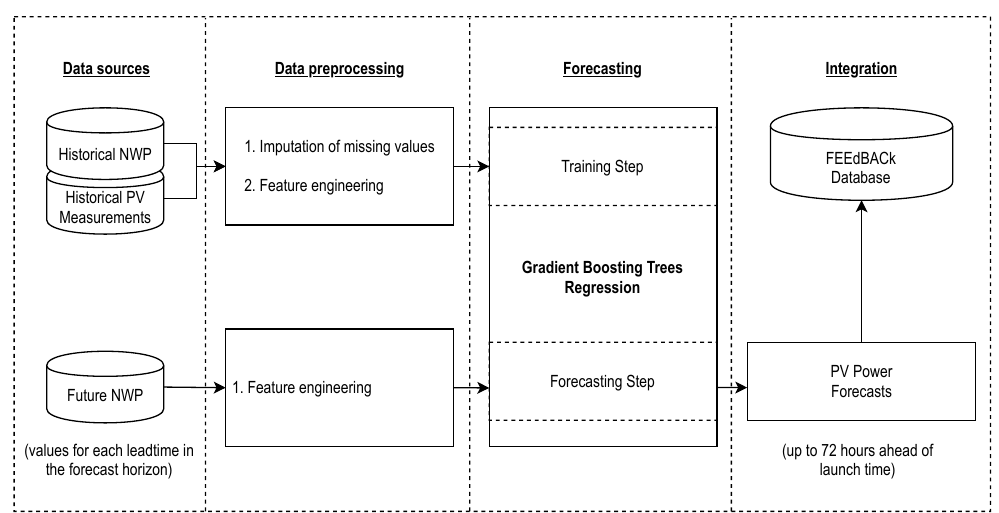
Figure 15. Block-scheme of the pv forecasting